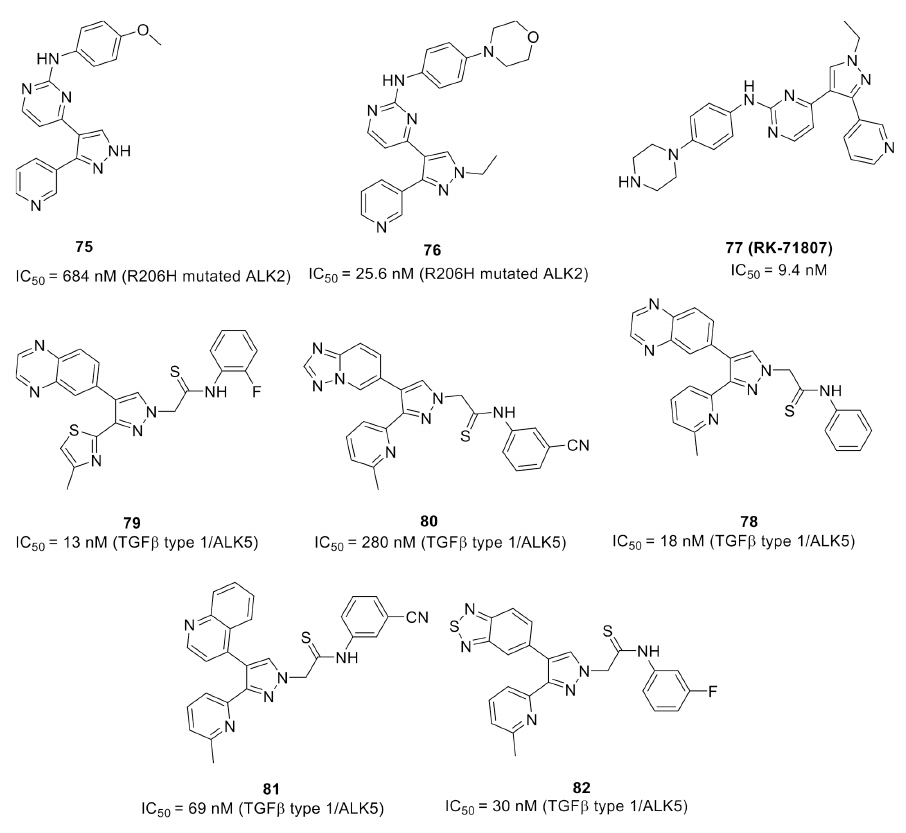
Figure 80. Structures of pyrazole-based TGF β /ALK inhibitors and their IC 50 values.